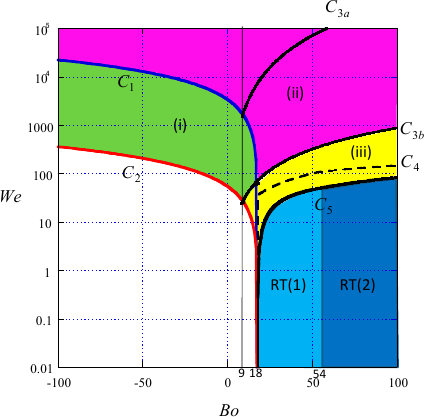
Figure 15. Turbulent atomization mode map [65]. The blue area (RT(1) and RT(2)) is the regime of the Rayleigh–Taylor mode. The other colored areas (( i ), ( ii ) and ( iii )) are for the resonant mode. Details can be found in [65].